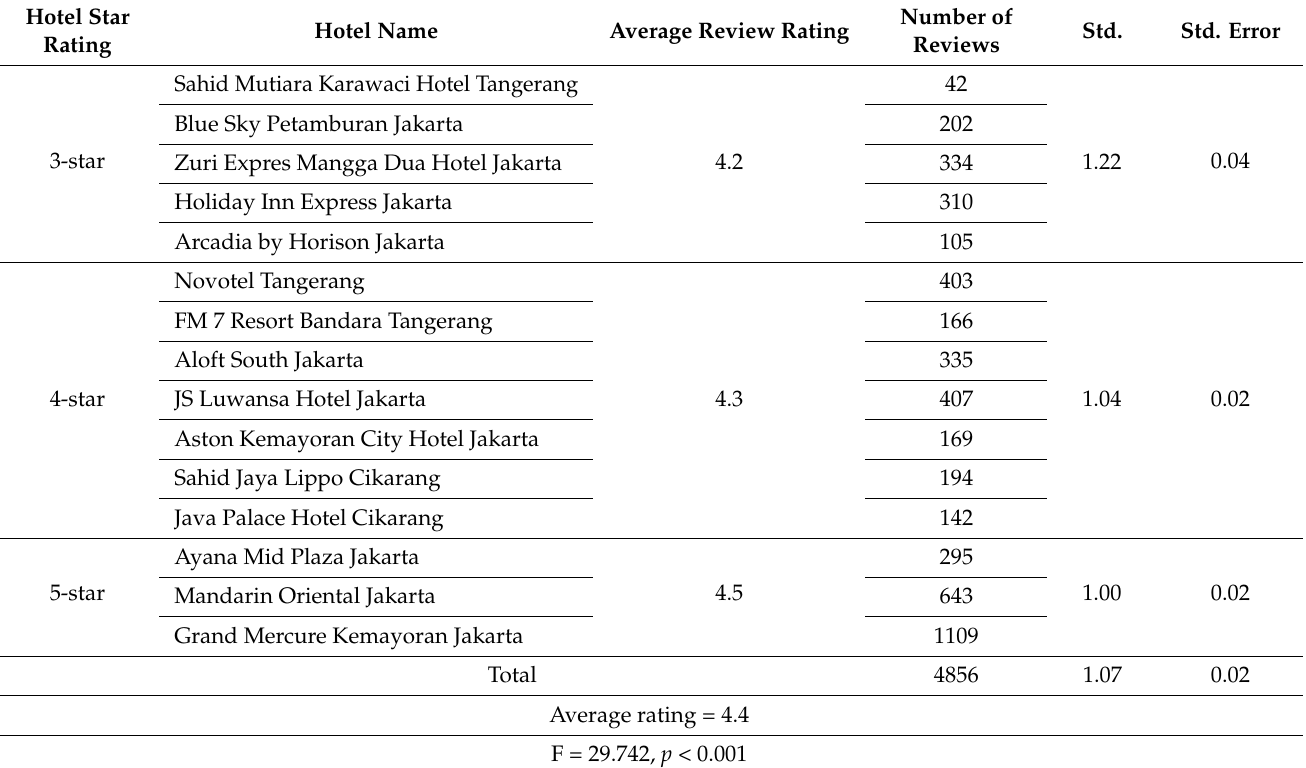
Table 1. Hotel reviews included in the